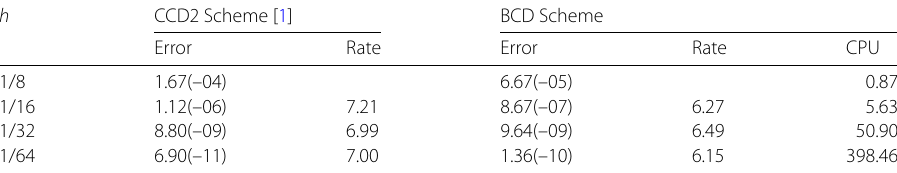
Table 3 The maximum absolute error and convergence rate for Problem 2 with ε = 10 –3